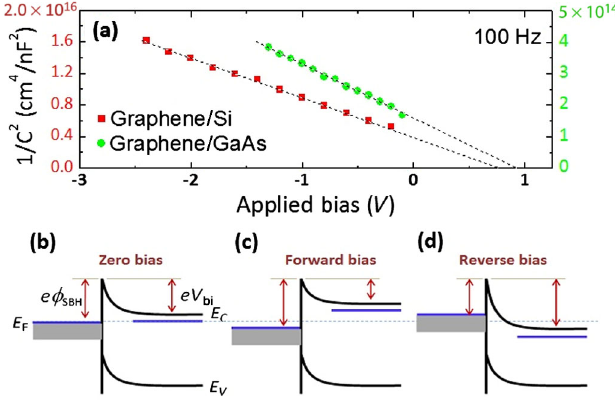
FIG. 7. (a) Plots of the inverse-square capacitance ( 1 =C 2 ) vs applied bias ( V ) for graphene =n - Si (red squares and the mark- ings on the left-hand y axis) and for n -GaAs (green circles and the markings on the right-hand y axis) at 300 K and 100 Hz show a linear dependence, implying that the Schottky-Mott model provides a good description. The interception on the abscissa ), which can be correlated to gives the built-in potential ( V bi the Schottky-barrier height, while the slope of the linear fit (cid:5) (cid:5) . Extracted (cid:3) and N values are listed in gives 2 =eN s D 0 SBH D Table I. Also shown are proposed Schottky-band diagrams of graphene/semiconductor junctions for (b) zero, (c) forward, and (d) reverse